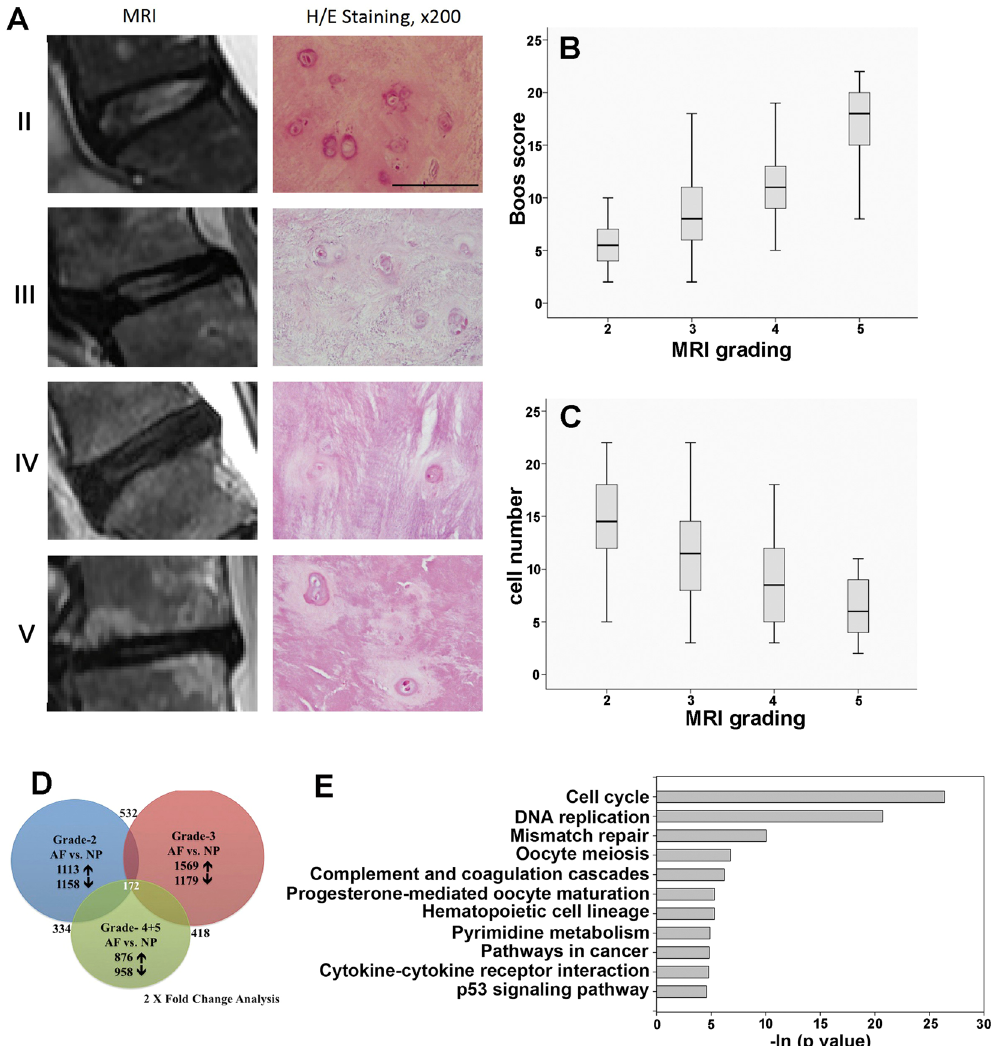
Figure 1. Histology of intervertebral disc in discectomy patients. ( A ) Typical MRI images of patients with Pfirrmann grades 2 to 5. NP cell density and extracellular matrix decreased with the IVD degenerative process, and round cartilage-like cells are replaced by fibroblasts (right column H/E, 200 × ). Scale = 100 μ m. ( B ) Comparison of the Boos score with the MRI grade, p < 0.001 by one-way ANOVA method. ( C ) Comparison of cell number with MRI grade, cell number was counted in one field at 200 × magnification under a microscope, p < 0.001 calculated by one-way ANOVA. ( D ) Proportional Venn diagram illustrating the genes significantly altered by AF and NP at different grades. The number of genes (fold change threshold > 2) unique to each comparison that were increased or decreased are listed next to arrows indicating the direction of change. The Venn diagram reveals a core of 172 genes that were changed in AF compared with NP across all grades. The large number of unique gene expression changes in each condition illustrates that the gene expression is altered by the clinical stage of the patient (blue = grade 2, red = grade 3, green = grade 4 & 5). ( E ) Functional analysis of the differentially regulated genes was carried out using Kyoto Encyclopedia of Genes and Genomes (KEGG) database (http://www.kegg.jp/ or http://www.genome.jp/kegg/). The functional annotation clusters are shown as Pathways that had a p value <